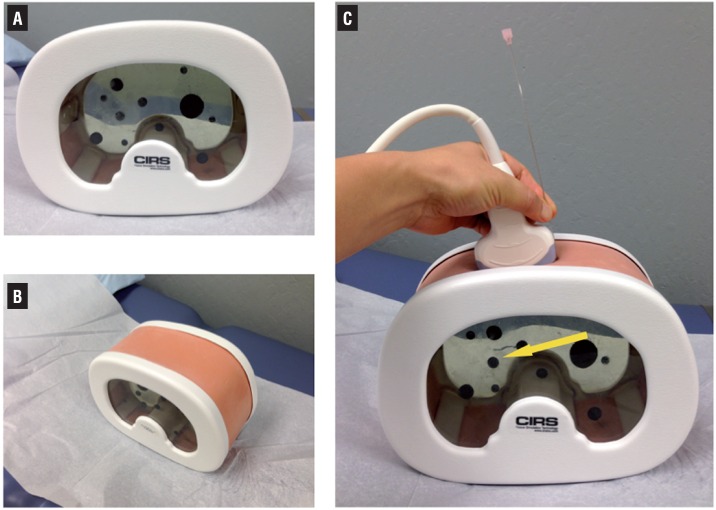
Abdominal training phantom used for ultrasound-guided needle placement time trial. The model has randomly distributed targets, visible in lateral (A) and oblique (B) views. Panel C demonstrates positioning of the ultrasound probe and needle used during the time trial. Participants were asked to place the needle into the black circular target indicated by the arrow.